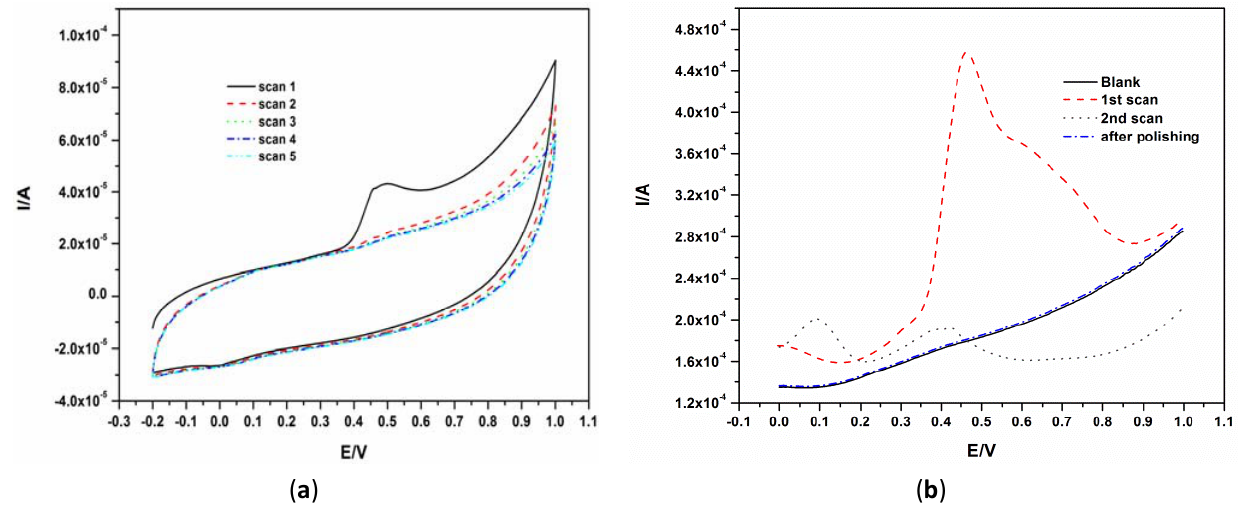
Figure 2. ( a ) CVs of 40 µM BPA in 0.1 M phosphate buffer solution. The scan rate was 50 mV·s − 1 and five scans were recorded; ( b ) SWV for 40 µM BPA in phosphate buffer solution at pH 10 at an amplitude of 50 mV and a frequency of 25 Hz. The ‘after polishing’ scan was recorded in blank phosphate buffer solution.